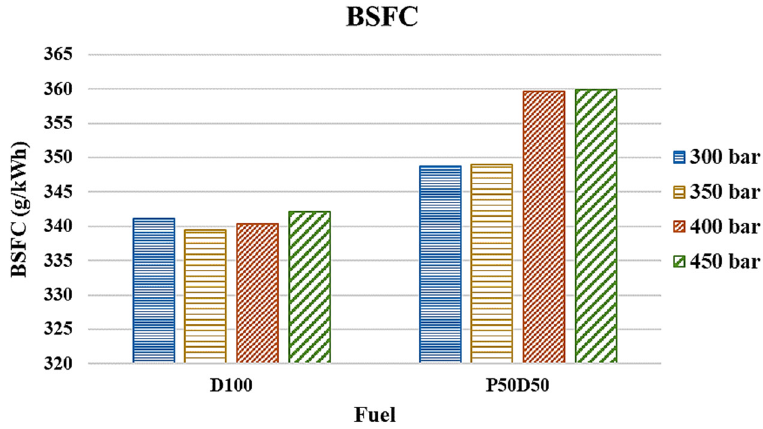
Figure 4. BSFC under various injection pressures.